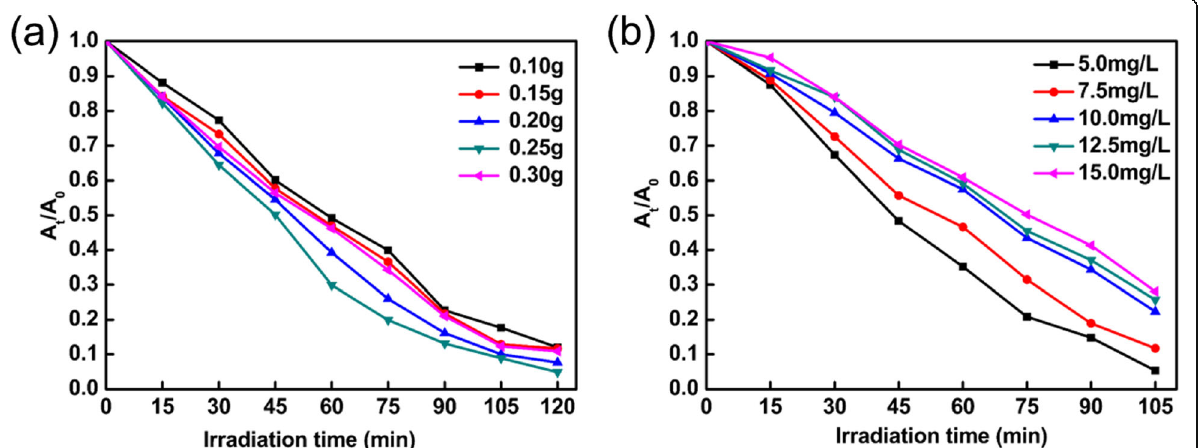
Fig. 8 Effect of ( a ) Bi 2 WO 6 /2 g/L GO dosage and ( b ) initial concentration of the dye on the removal rate of RhB by Bi 2 WO 6 /2 g/L GO deposited PET fabric